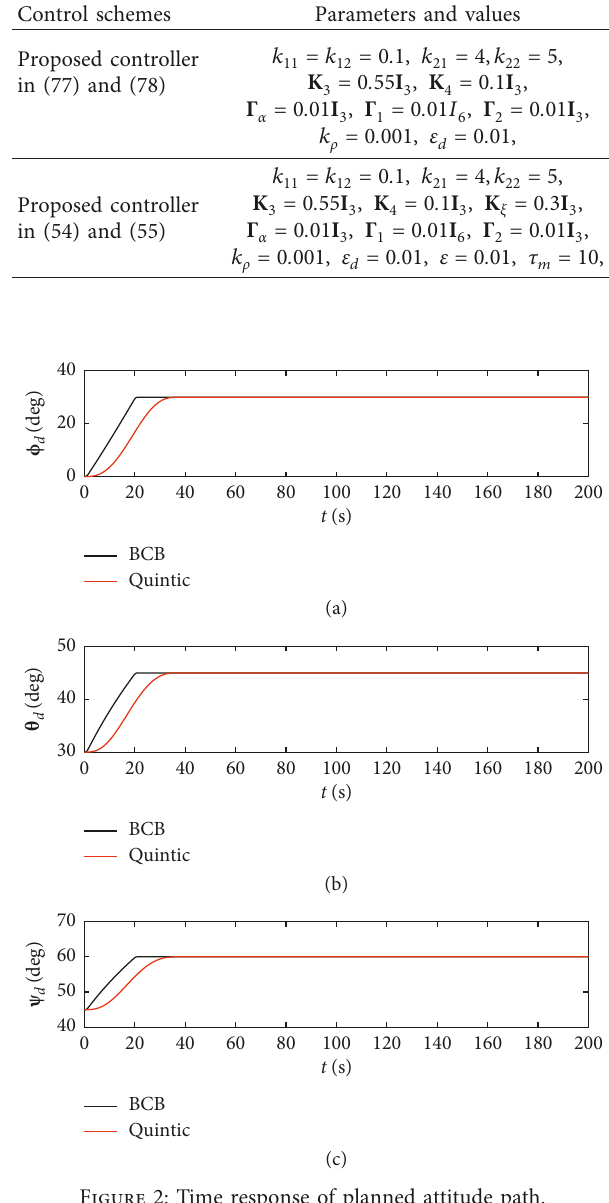
Figure 2: Time response of planned attitude